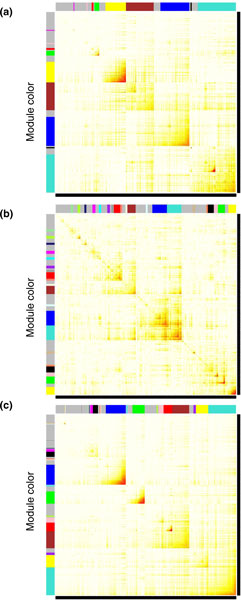
Gene bionetwork cluster analysis of 11 male and female tissues with corresponding gene
modules. Topological overlap matrixes of the gene co-expression network consisting of genes
differentially expressed in 11 tissues of the F3 vinclozolin lineage compared to F3 control lineage
animals. Genes in the rows and columns are sorted by an agglomerative hierarchical clustering
algorithm. The different shades of color signify the strength of the connections between the nodes
(from white signifying not significantly correlated to red signifying highly significantly
correlated). The topological overlap matrix strongly indicates highly interconnected subsets of
genes (modules). Modules identified are colored along both column and row and are boxed. (a)
Matrixes of the combined network for six male tissues. (b) Matrixes of the combined
network for five female tissues. (c) Matrixes of the combined network for 11 male and female
tissues.